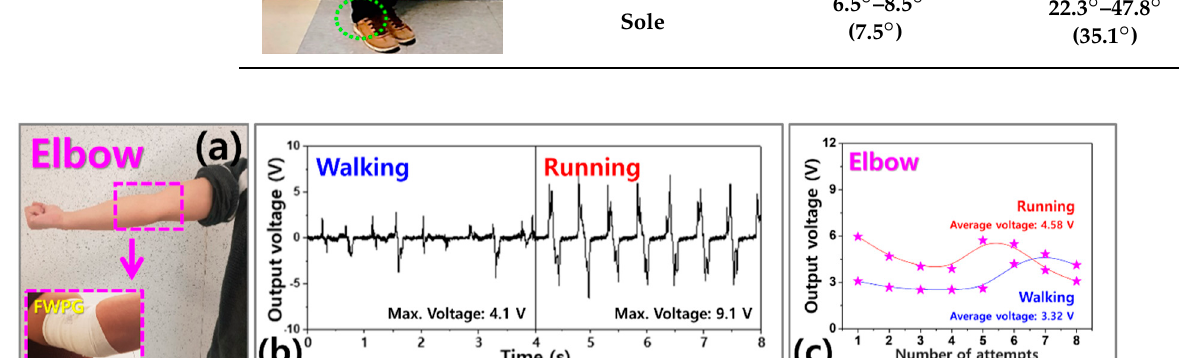
Figure 8. ( a ) Photograph of an attached FWPG from a human’s elbow. ( b ) Output voltage of the FWPG from the elbow when walking and running. ( c ) Average voltage of the FWPG from elbow when a human is walking and running.